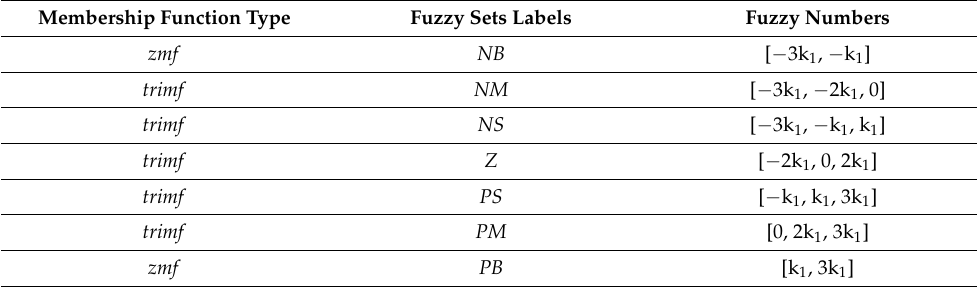
Table 3. Membership function, fuzzy set labels, and fuzzy numbers representation for Figure 5.